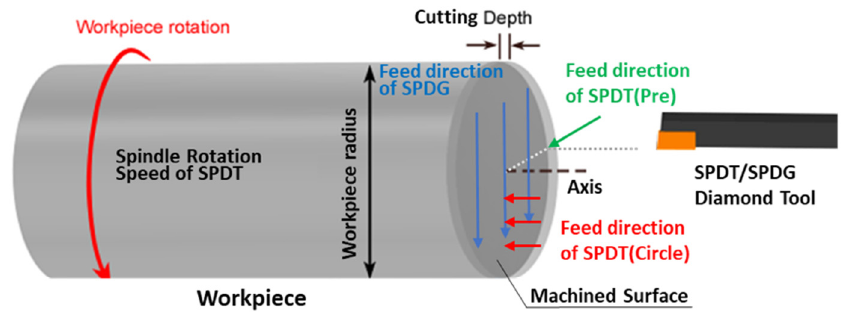
Figure 6. Processing principle of SPDT and SPDG. In the preliminary process of SPDT(Pre), the workpiece turns at a high cutting speed, and the diamond tool feeds in the radial direction until the machined surface becomes smooth. For the concentric circle groove processing in SPDT(Circle), the workpiece keeps spinning, and the diamond tool remains stationary after every certain position of feed direction of SPDT(Circle). For the parallel straight groove processing in SPDG, the workpiece remains stationary and the diamond tool feeds in a series of parallel and equally spaced radial directions.